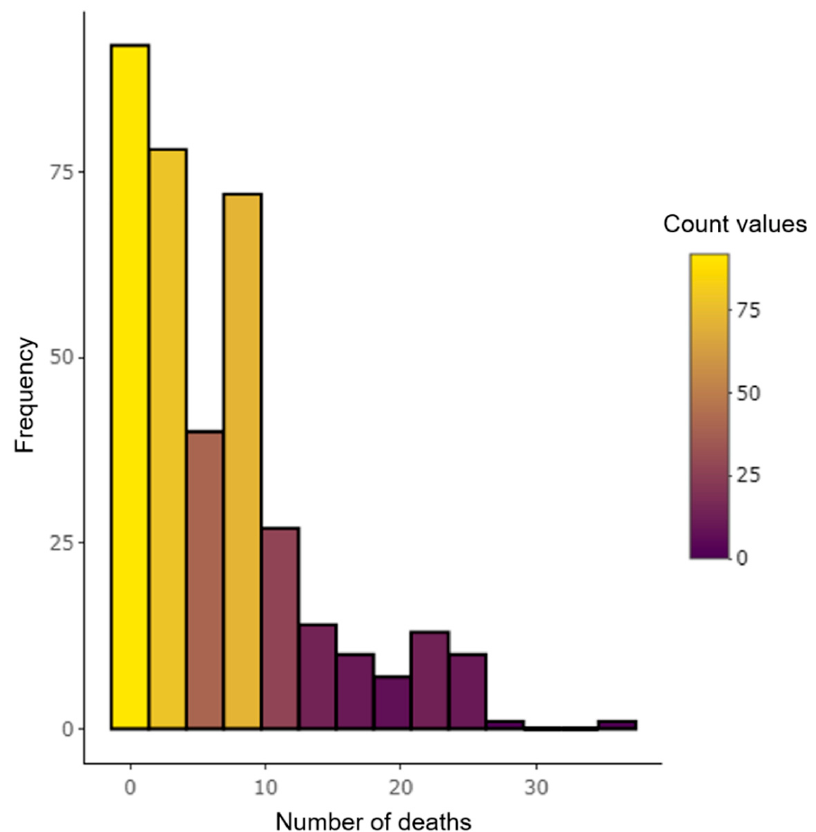
Figure 4. Histogram of deaths due to COVID-19 reported to the Municipal Health Department of Uberlândia.